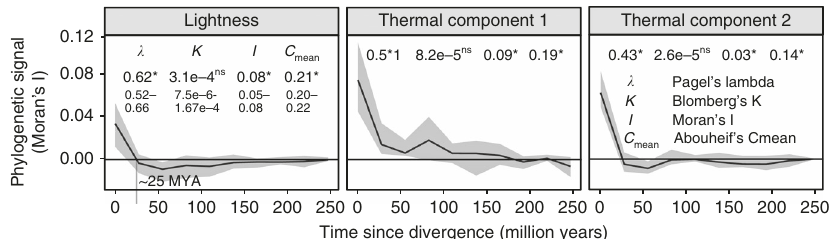
Fig. 5 Phylogenetic signal of species mushroom lightness and thermal components. The phylogenetic signal was calculated as four different measures, and graphically displayed based on Moran ’ s I (phylogenetic correlogram). Species occupying at least 10 grid cells were used. The con fi dence interval (CI), indicated by shading, was based on 99 bootstraps. Signi fi cant phylogenetic signal was detectable only over very short phylogenetic distances, i.e., between closely related taxa (CI above/below null line). To estimate overall phylogenetic signal, we used (from left to right): Pagel ’ s lambda ( λ ), Blomberg ’ s K , Moran ’ s I and Abouheif ’ s C mean. The measures of phylogenetic signal show a low signal except for Pagel ’ s lambda, which displayed medium-high values. Based on simulations, Münkemüller et al. 71 showed that Moran ’ s I and Abouheif ’ s C mean of 0.1 and 0.2 each, indicate a strength of Brownian motion of approximately 0.3 (on a scale from 0 to 1). Signi fi cance of the overall phylogenetic signals was tested based on 99 randomizations. Phylogenetic signal for lightness was further tested for 100 alternative trees and the range of values is given below the lightness values for the maximum likelihood phylogeny. For other environmental variables see Supplementary Fig. 9. Source data are provided in Supplementary Data 1, 2,